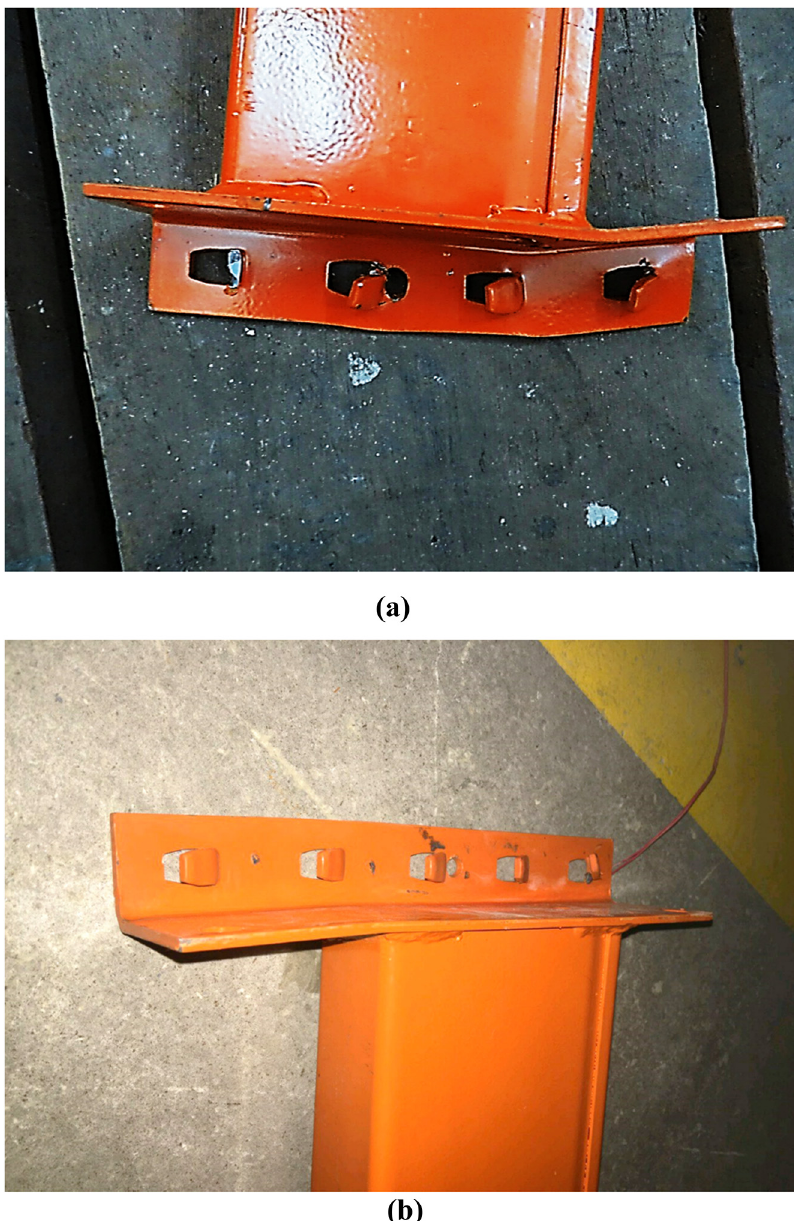
Fig 9. Deformation of tabs. (a) Deformation of tabs in connector ‘ A ’ , (b) Deformation of tabs in connector ‘ B ’